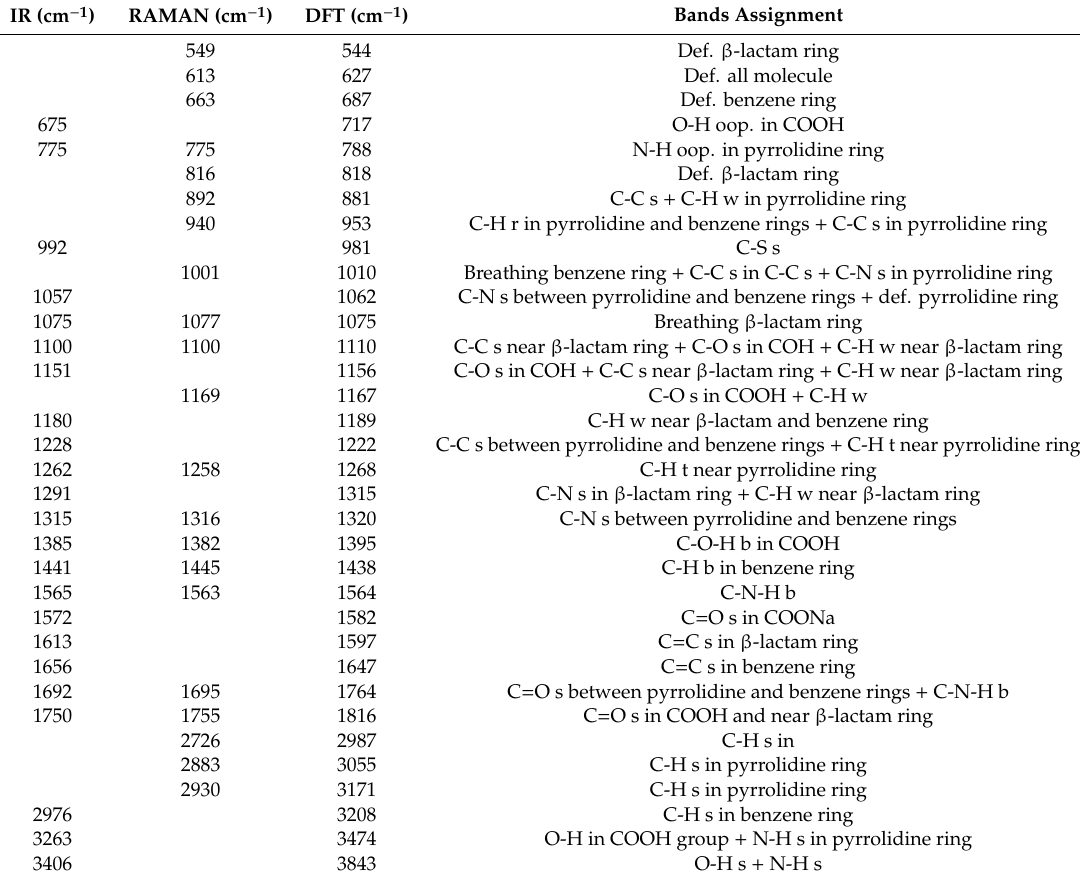
Table 1. Selected characteristic vibrionic features of ertapenem in the form of the sodium salt (ERP); (s-stretching, b-bending, w-wagging, t-twisting, oop-out of